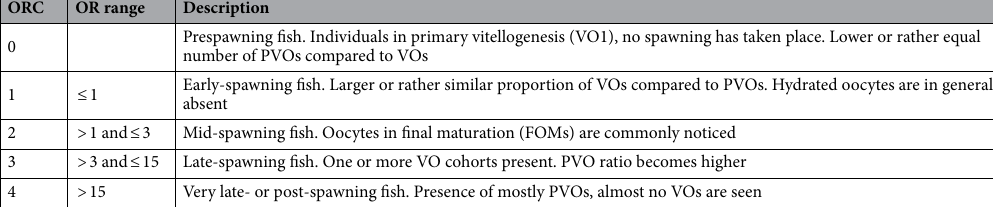
(Supplementary, Table S1) but 230 µm was found to be a conservative figure in a series of pilot tests. Overall, the studied PVOs ranged currently from 100 to 230 µm (thus we did not include the tiniest PVOs, the PVO1 (Supplementary, Table S1), and the following CA, VO and final oocyte maturation (FOM) from 231 to 1100 µm, where the given lower (100 µm) and higher extreme (1100 µm) follow from method-defined restrictions (see above and below).